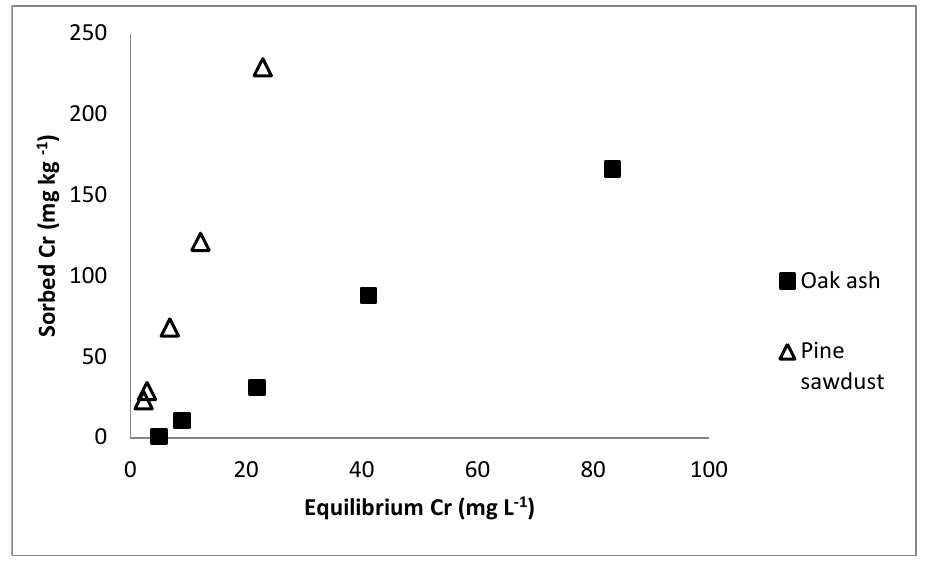
Figure 1. Sorption curves for oak wood ash and pine